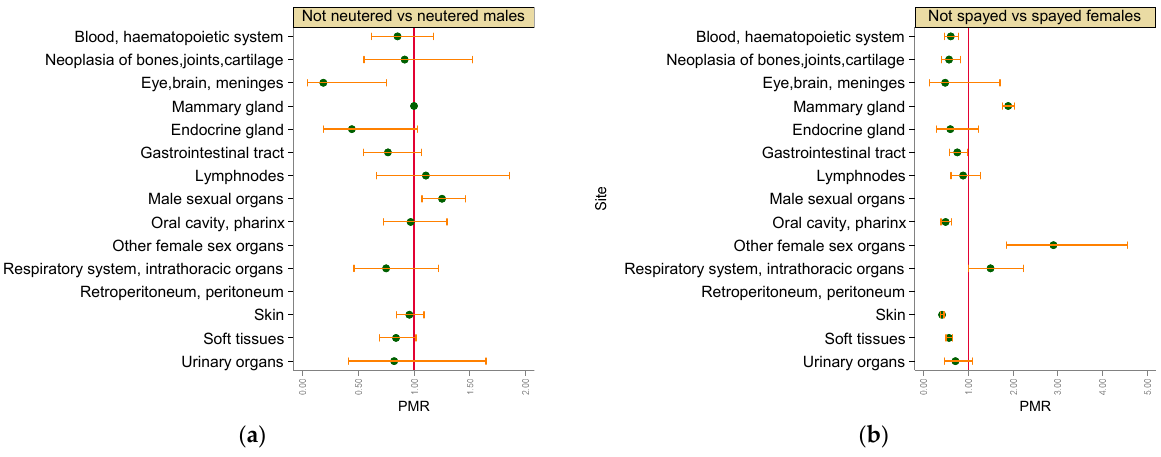
Figure 5. Proportional morbidity ratios of malignant tumours by topography: ( a ) neutered males vs. not neutered males, ( b ) spayed females vs. not spayed females. Dots: age-class-adjusted PMRs, bars: lower and upper bound of 95% confidence interval. A vertical reference line indicates PMR = 1. ( a ) Males; ( b ) females.